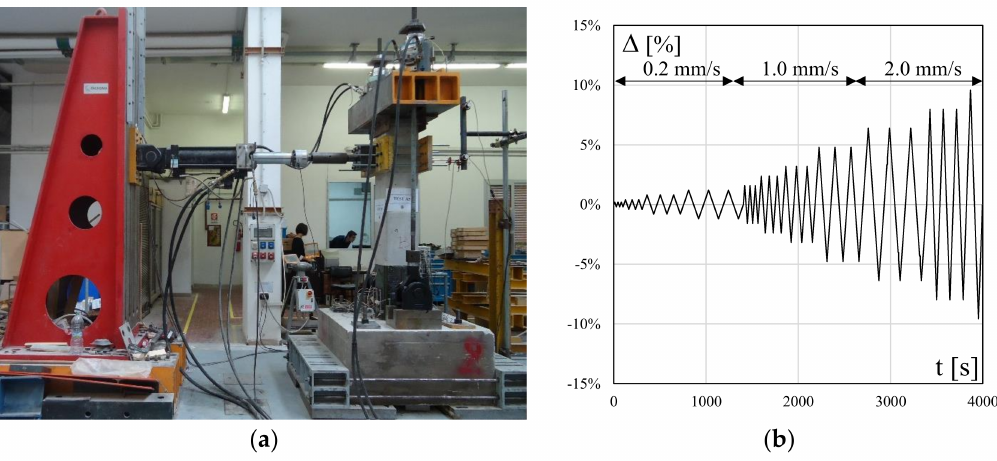
Figure 5. ( a ) Test setup; ( b ) loading